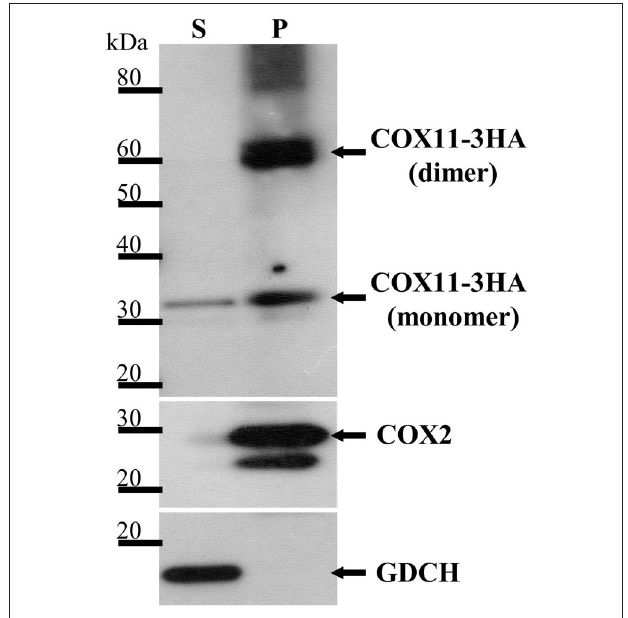
FIGURE 3 | COX11-3HA is an integral membrane protein. Pure mitochondria were isolated from plants expressing COX11-3HA and subjected to Na 2 CO 3 treatment to separate soluble (S) from membrane and membrane-associated proteins, which remained in the pellet (P). The S and P fractions (from 100 µ g of mitochondria) were analyzed by Western blotting, using antibodies against HA (from human influenza hemagglutinin) to detect COX11-3HA of the theoretical molecular weight of 30kDa after cleavage of the predicted targeting signal. The purity of the fractions was assessed by detection of the marker COX2 (cytochrome c oxidase subunit 2, theoretical molecular weight of 30kDa) for integral and GDCH (glycine decarboxylation complex subunit H, theoretical molecular weight of 16kDa) for soluble proteins. All proteins were detected on the same membrane, which was stripped between each